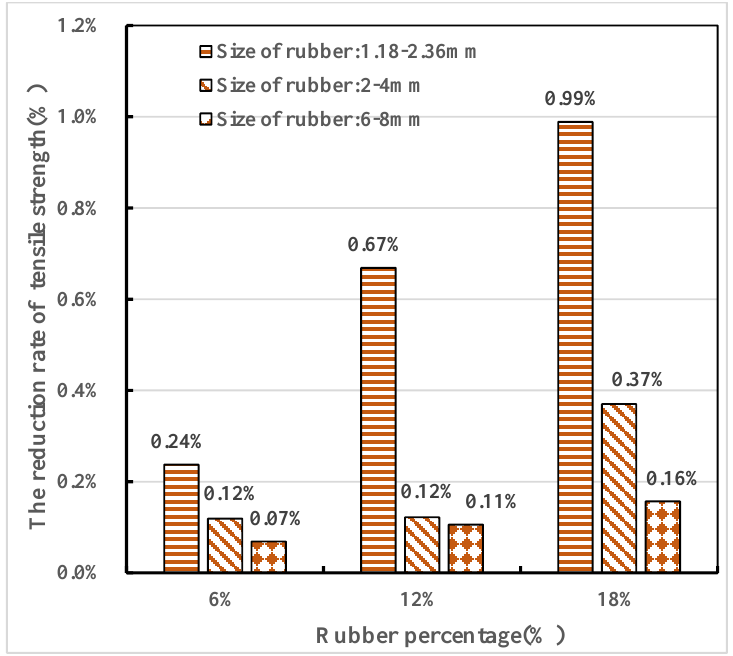
Figure 12. The tensile strength reduction rate of CRM after ITZ is considered.